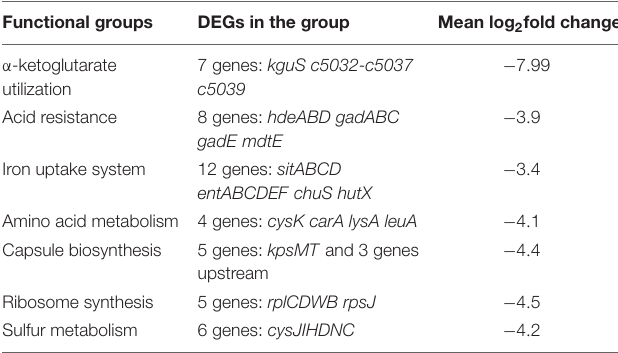
TABLE 1 | Information about DEGs with log 2 fold change ≥ 3 in the RNA-seq analysis. Functional groups